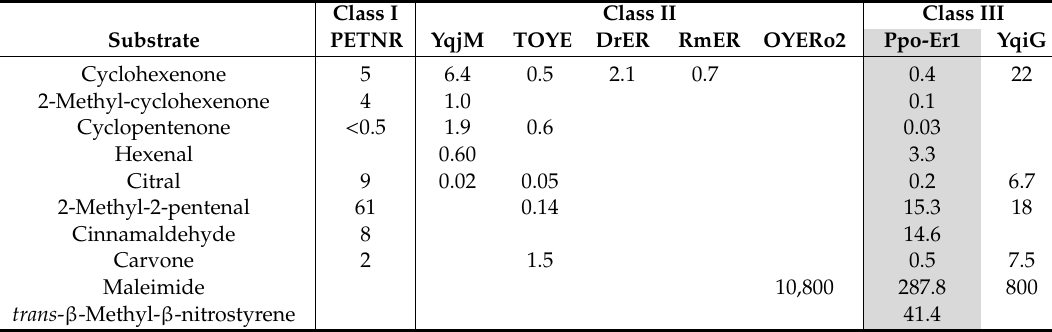
Table 2. Comparison of the catalytic e ffi ciencies (mM − 1 s − 1 ) of a range of known old yellow enzymes